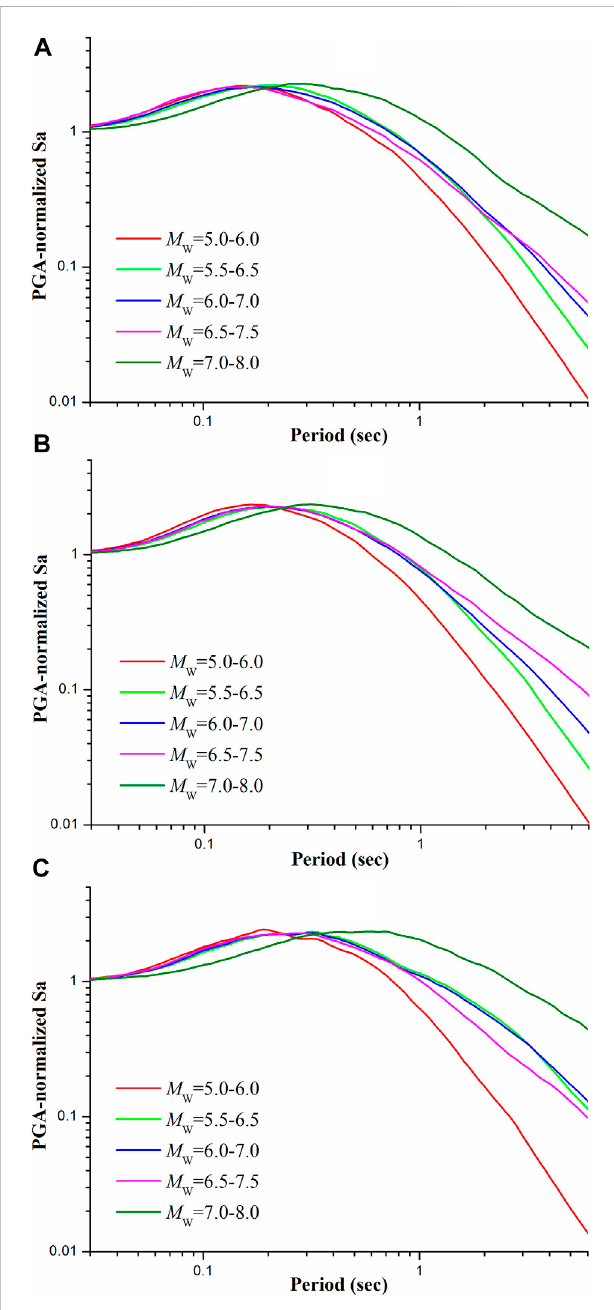
FIGURE 3 Mean values for PGA-normalized Sa with different moment magnitude intervals on (A) site class I, (B) site class II, and (C) site class III.